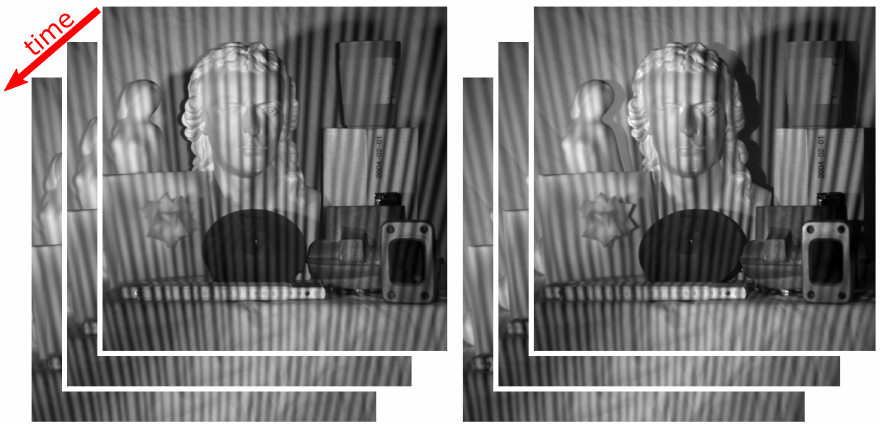
Figure 8. Rectified images of the left and right camera (brightness and contrast adjusted for better visibility).